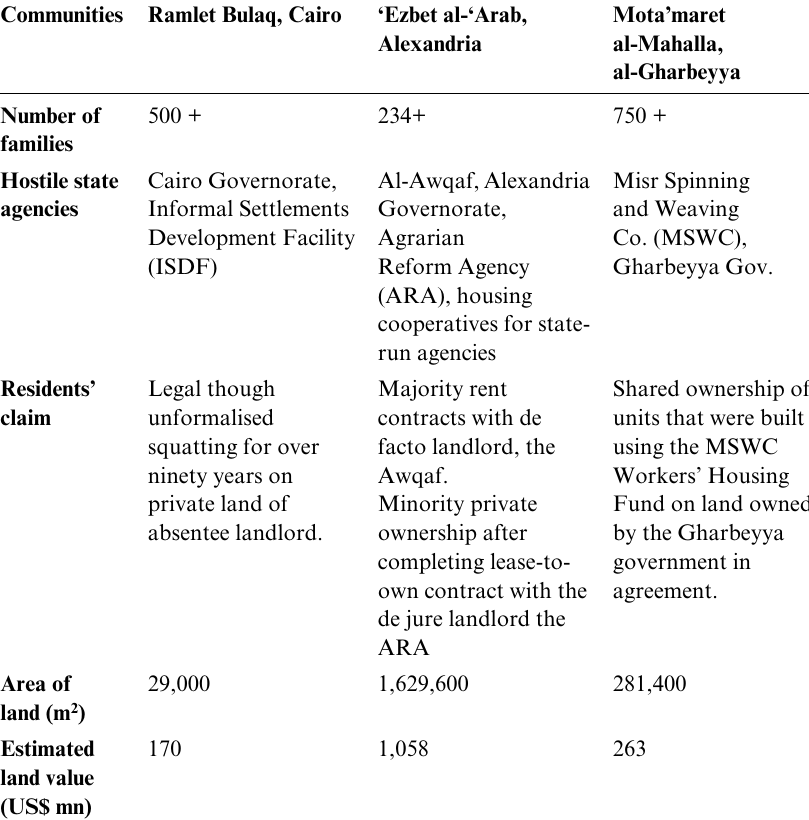
Table 1. Overview of the three Communities Covered in this Study Communities Ramlet Bulaq,